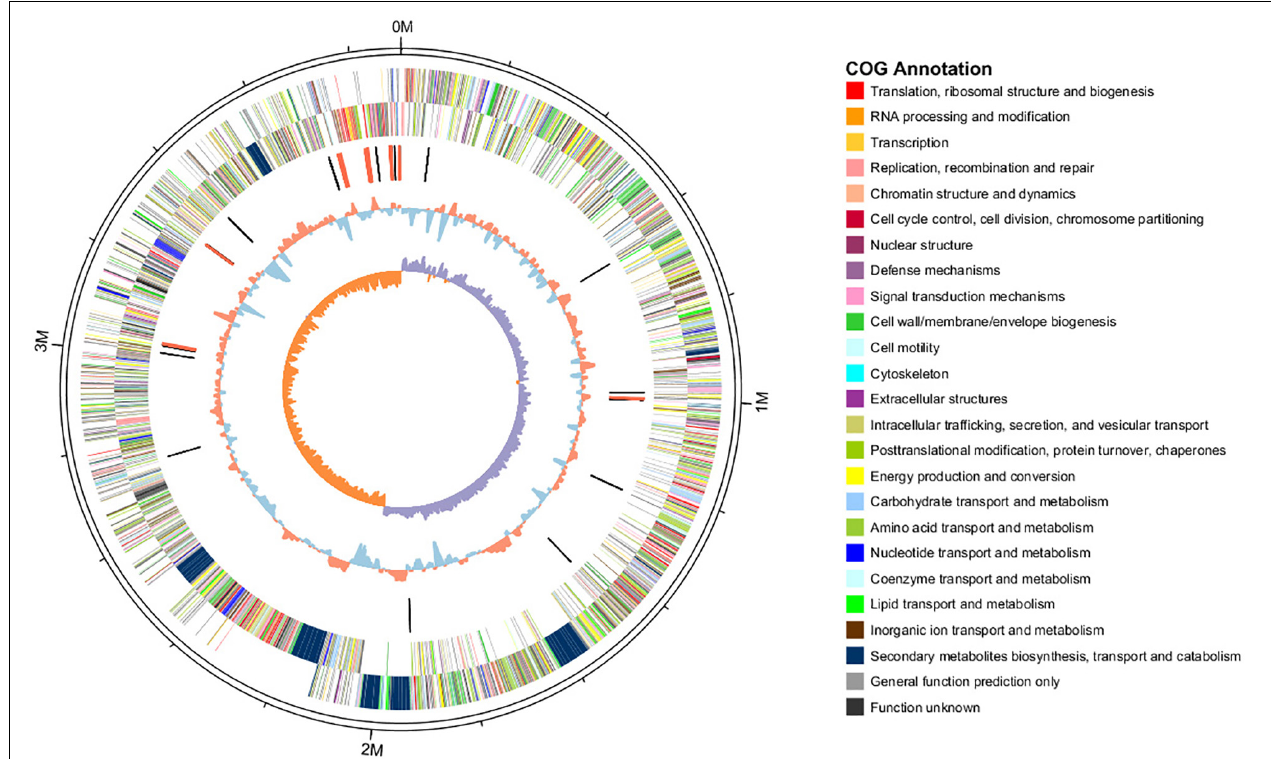
FIGURE 1 | Circular representation of B. velezensis HAB-2 genome. From outer to inner circle: first and second circles are positive and negative chain genes, respectively, all genes are color coded according to their COG annotation functions; third circle is ncRNA (black indicates tRNA and red indicates rRNA); fourth circle is GC content (red indicates greater than average value and blue indicates less than average); and fifth circle is GC skew (GC skew = [(G - C)/(G + C), purple indicates > 0 and orange indicates <